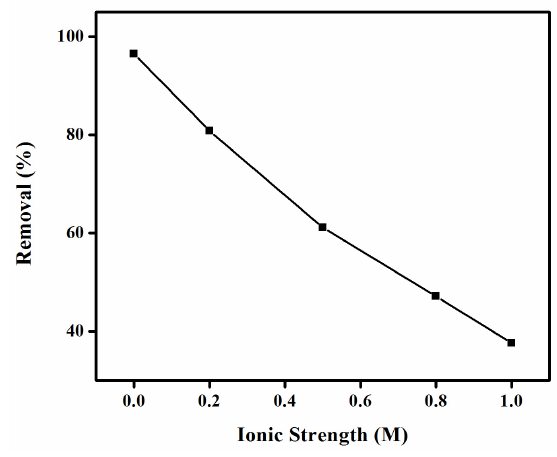
Figure 4. Effect of ìonic strength on the removal (%) of congo red using EBTAC.